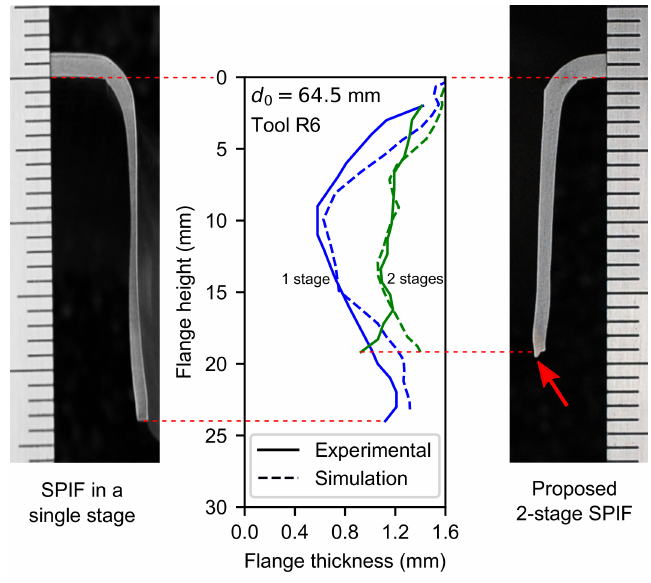
Figure 13. Views of hole-flange sections obtained by single-stage and two-stage SPIF experimental tests and comparison with numerical